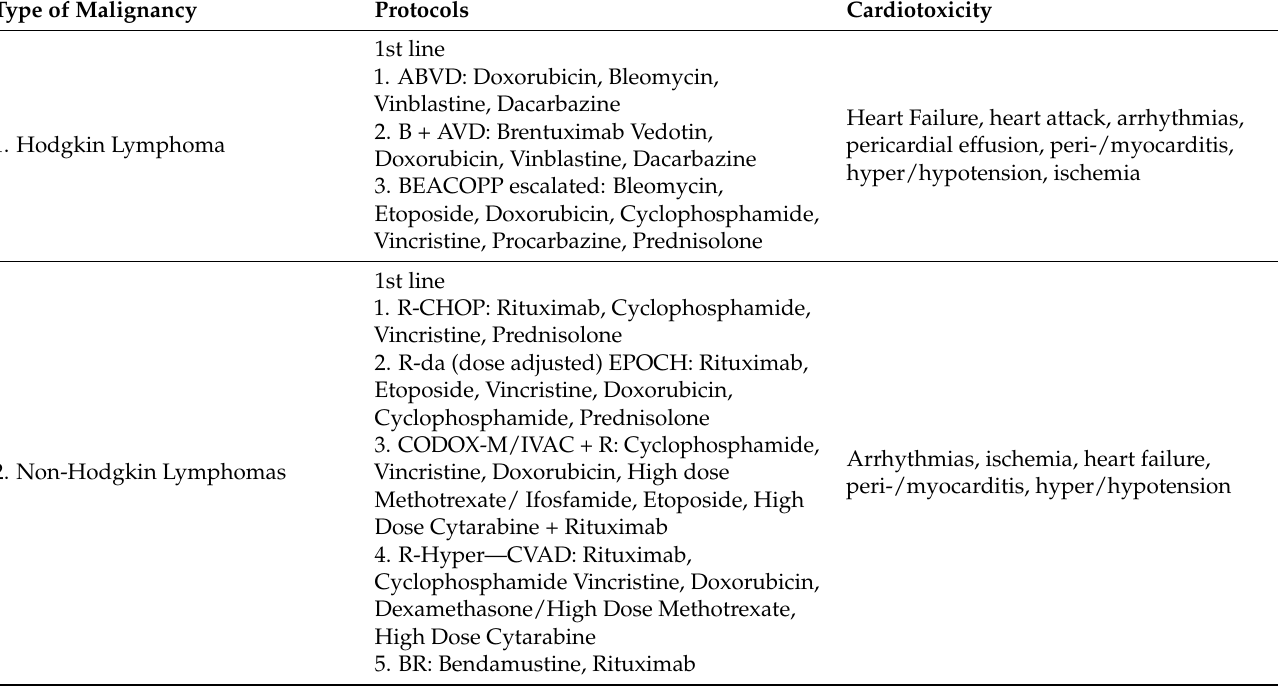
Table 2. Cardiotoxicity of the most common treatment protocols in different hematologic